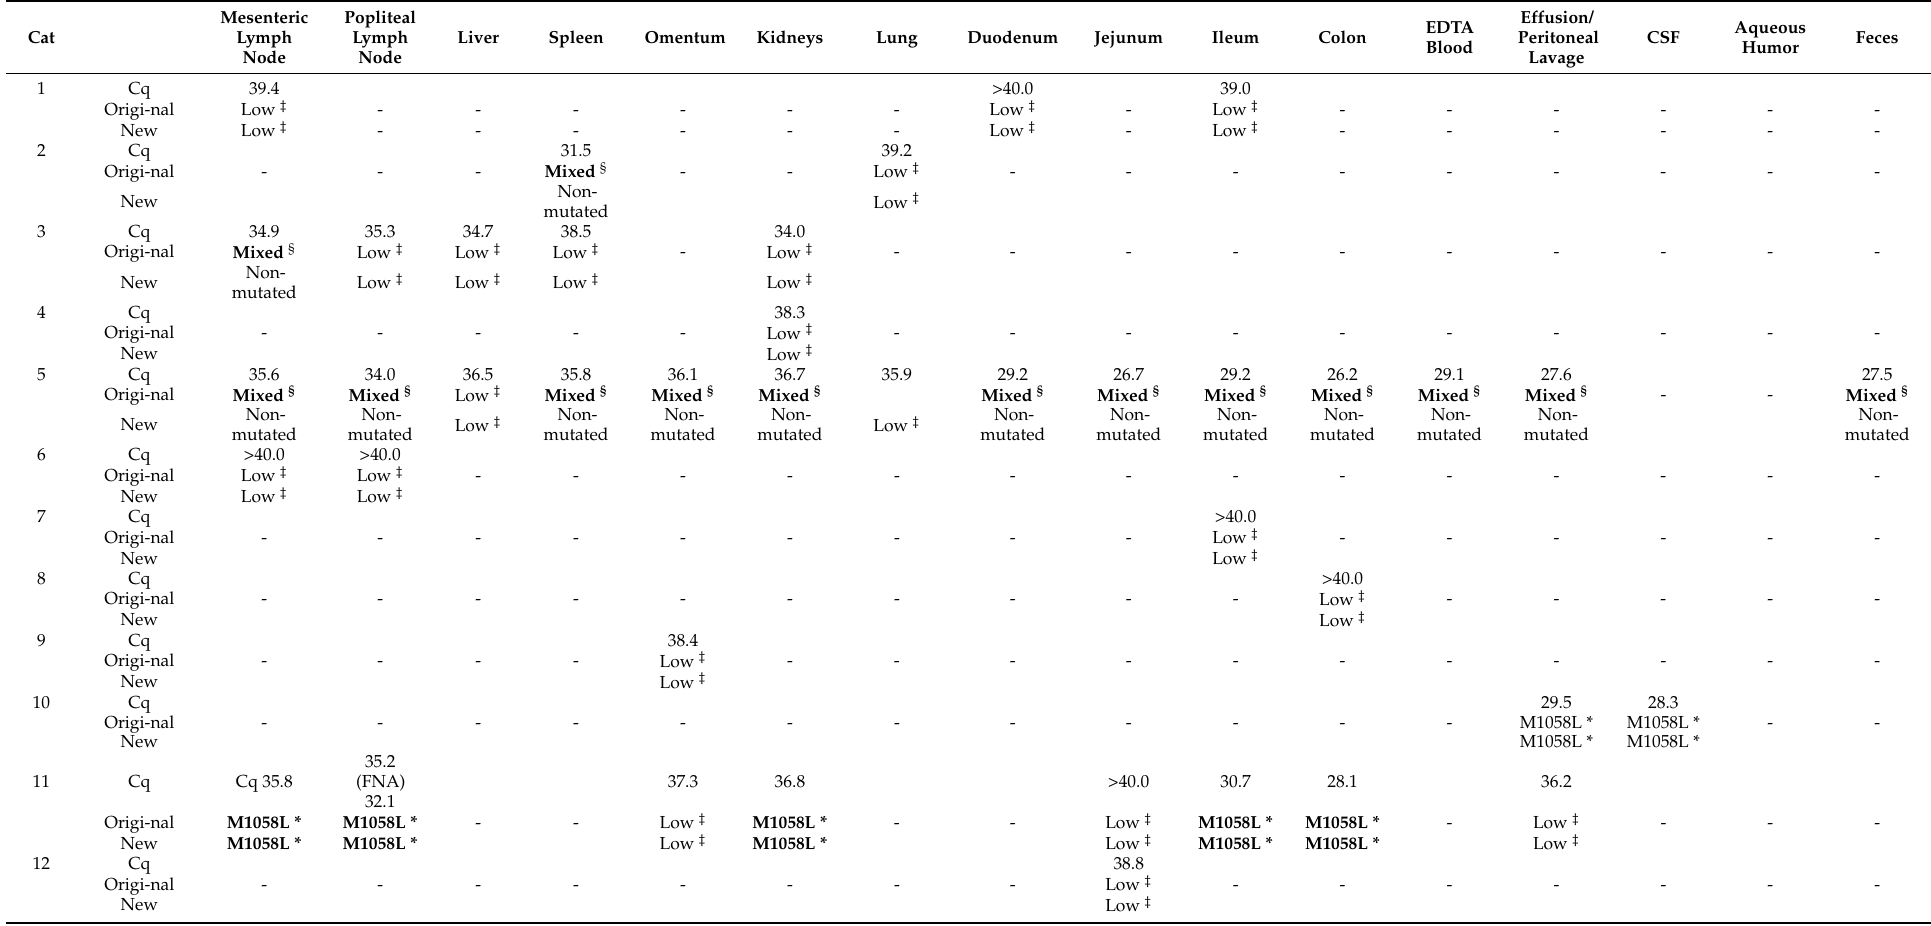
Table 2. Results of the commercial real-time feline coronavirus (FCoV) 7b gene and spike (S) gene mutation reverse transcription polymerase chain reactions (RT-qPCR) following the original algorithm and the new algorithm in all tissue, fluid, and fecal samples from the 21 cats positive for FCoV RNA in at least one